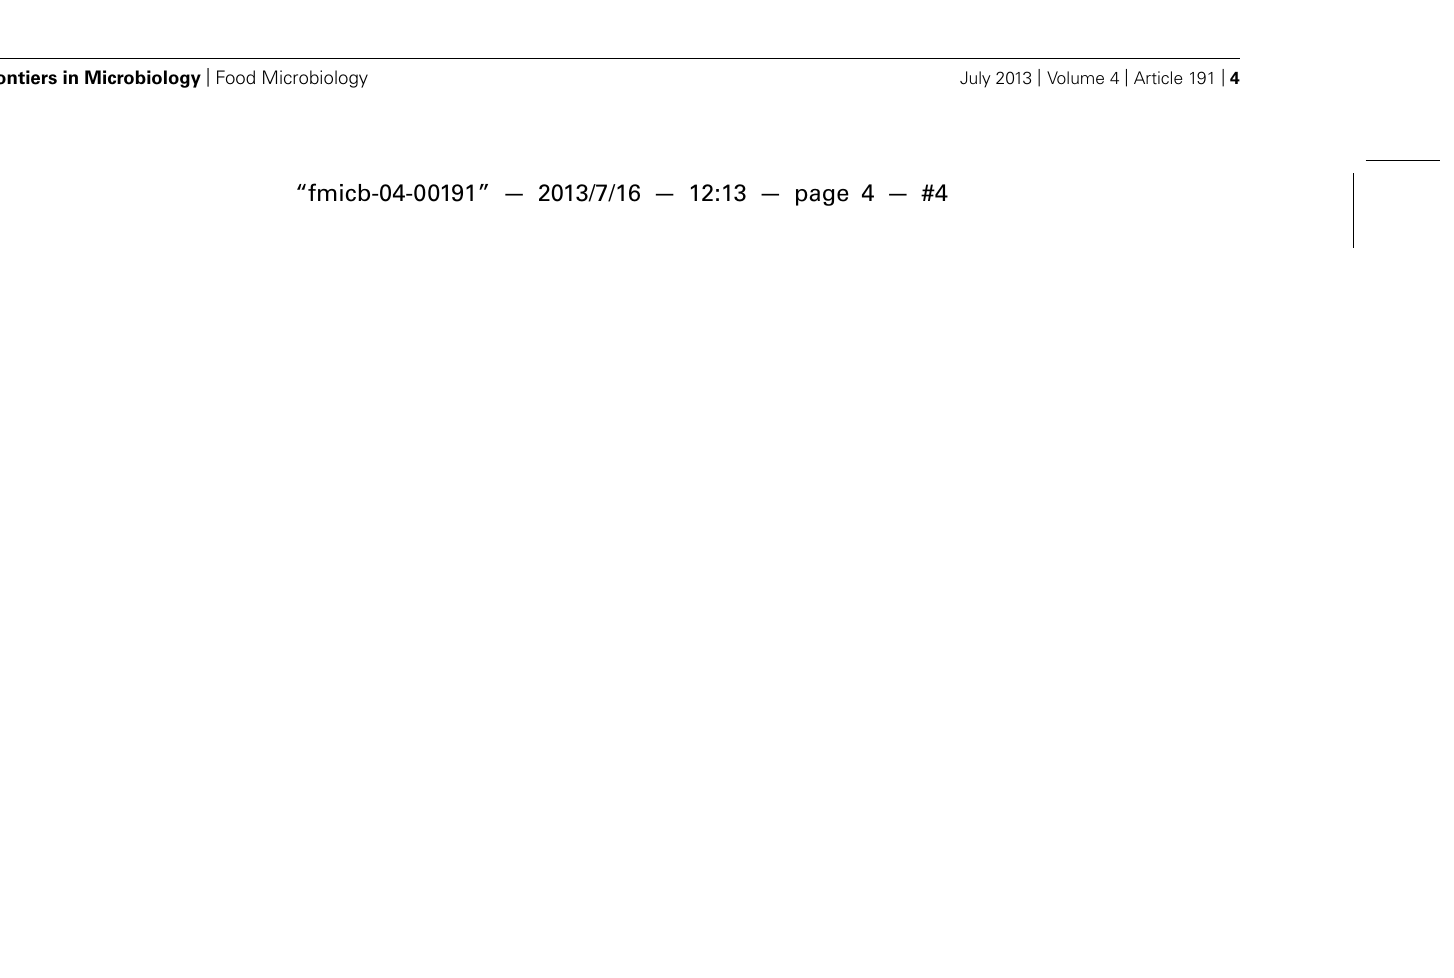
FIGURE 3 | Flow chart of a cheese-making process in which concentrated whey proteins and whey cream are being recycled. a A combination of heating and shearing is applied to whey protein concentrate, b whey is concentrated by means of ultrafiltration (Atamer etal.,